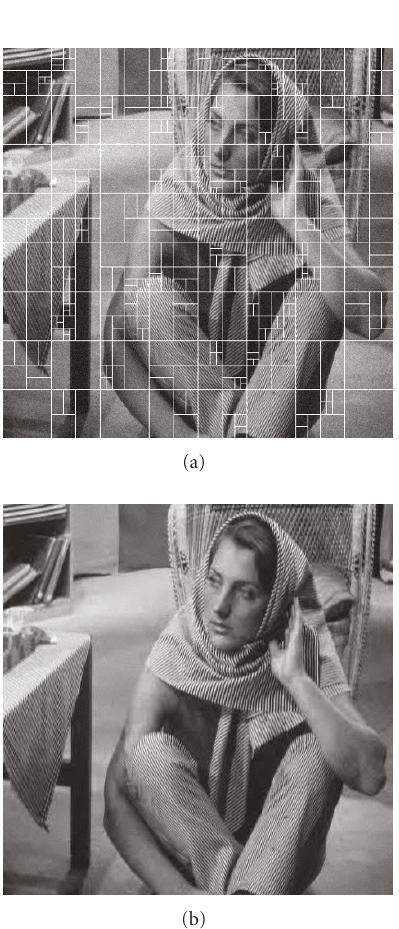
Figure 3: Noisy image Barbara and partition scheme for the coder ADCTC (a), compressed image with QS = 3 . 5 σ